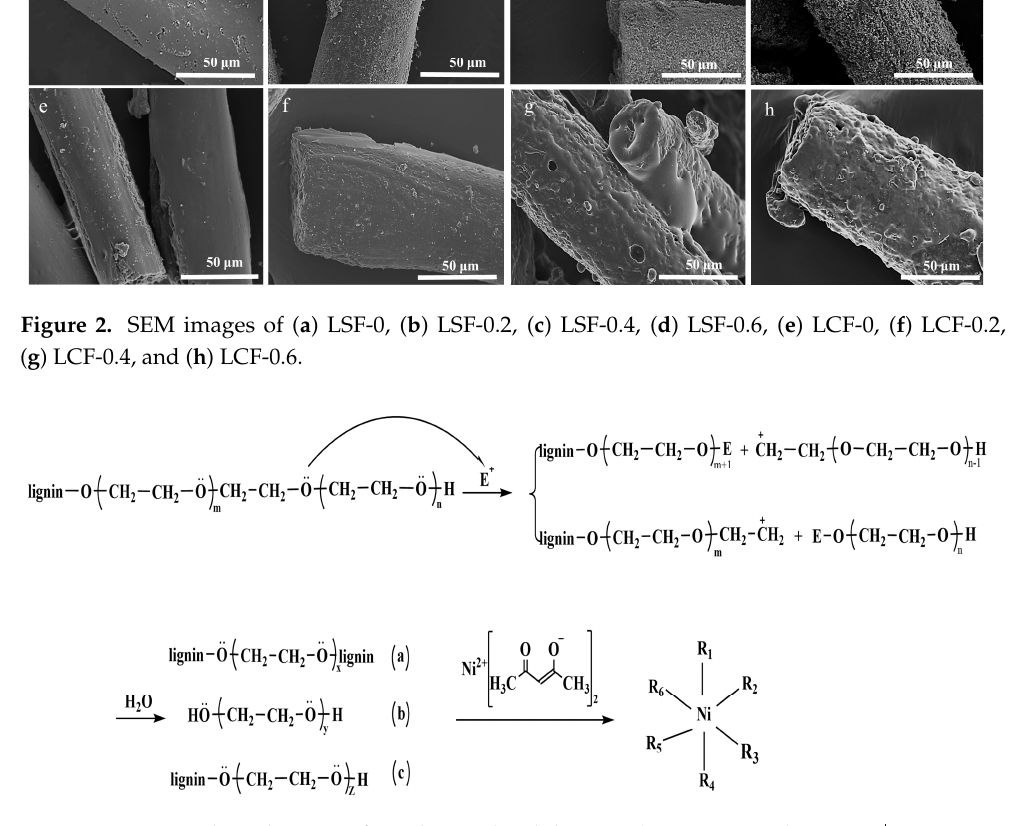
Figure 3. Proposed mechanism of LF chemical stabilization (m, n, x, y, and z ≥ 0; E + represents electrophiles, including H + and Ni 2+ ; R 1 , R 2 , R 3 , R 4 , R 5 , and R 6 represent reaction products a, b, c, acetylacetonate ligands, and other coordinating molecules).